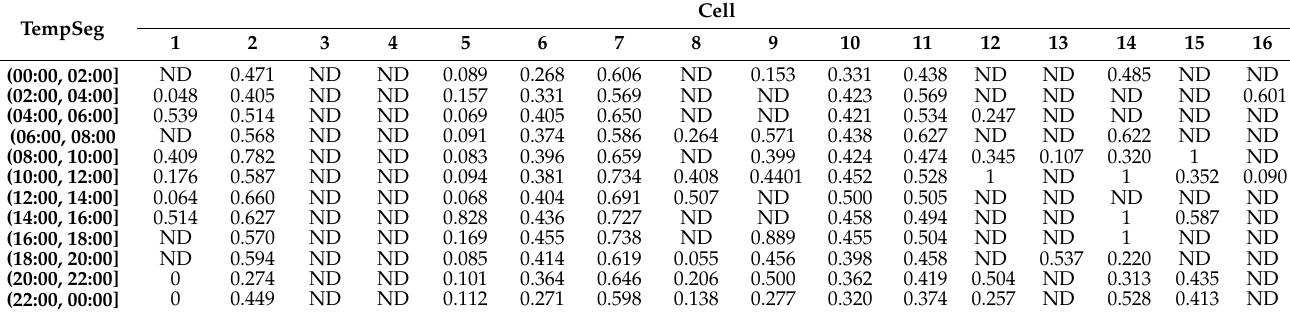
Table 2. Calculated speed limit rates for 3 August 2013 with MaxSpeed = 50 km/h. Cell